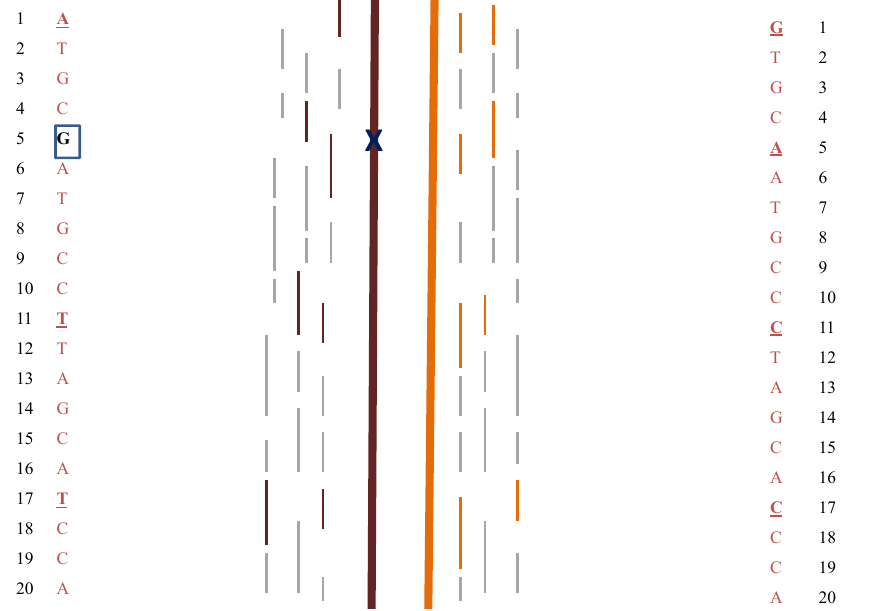
Figure 1. Illustration of SNP analysis in fetal DNA. Dark brown and light brown heavy lines indicate two homologs present in fetal DNA. Thin dark brown and light brown lines represent DNA fragments that may contain SNPs and map uniquely to their corresponding chromosome while thin grey lines are DNA fragments that can map to either homolog. 1–20 refers to representative positions along each chromosome, some of which are the sites of SNPs (bold, underlined bases). Analysis of the fragments present, comparison with the parent’s SNPs, and mapping to reference genome sequences allows construction of the fetal haplotypes. The analysis potentially allows identification of inherited disease causing mutations (e.g., position 5, G boxed) either through identification of the specific fragments with the mutation or through closely linked